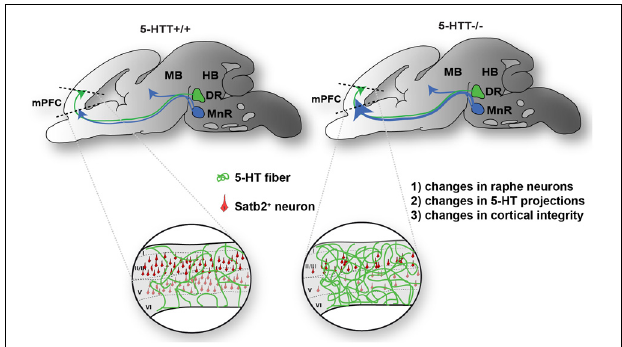
FIGURE 7 | Proposed model of the effect of 5-HTT deficiency on DR and MnR serotonergic neurite outgrowth during development. Cg, cingulate cortex; DR, dorsal raphe nucleus; HB, hindbrain; IL, infralimbic; MB, midbrain; MnR, median raphe nucleus; PL,